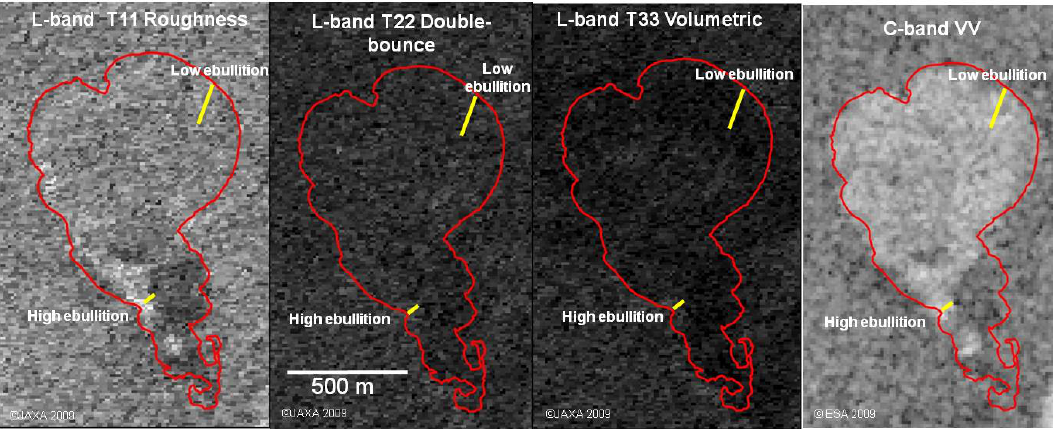
Fig. 7. A frozen thermokarst lake on the Seward Peninsula with floating ice on northern portion of lake and grounded ice at the southern portion shown in L-band T 11 , T 22, T 33, and C-band VV images acquired on 29 March 2009. The T 11 roughness component of quad-pol L-band shows some contrast between floating and grounded ice, but it also shows high absolute backscatter, seen as bright areas from high- methane ebullition areas, as determined by field measurements (yellow lines) in October 2008 (Engram et al., 2012). C-band VV shows the strongest contrast between floating and grounded lake ice. Area marked as high ebullition had 11.1% area of transect with ebullition gas bubbles, low ebullition had 5.1% of transect area containing